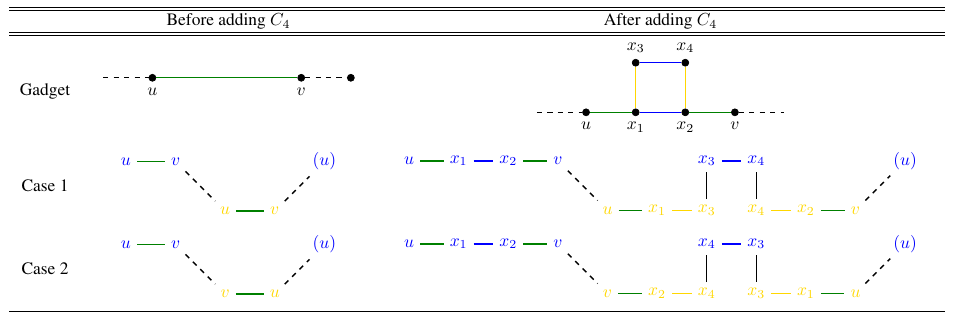
Fig. 6: Suppose we have a gadget in which uv is a green edge. By adding a C obtain a new gadget.